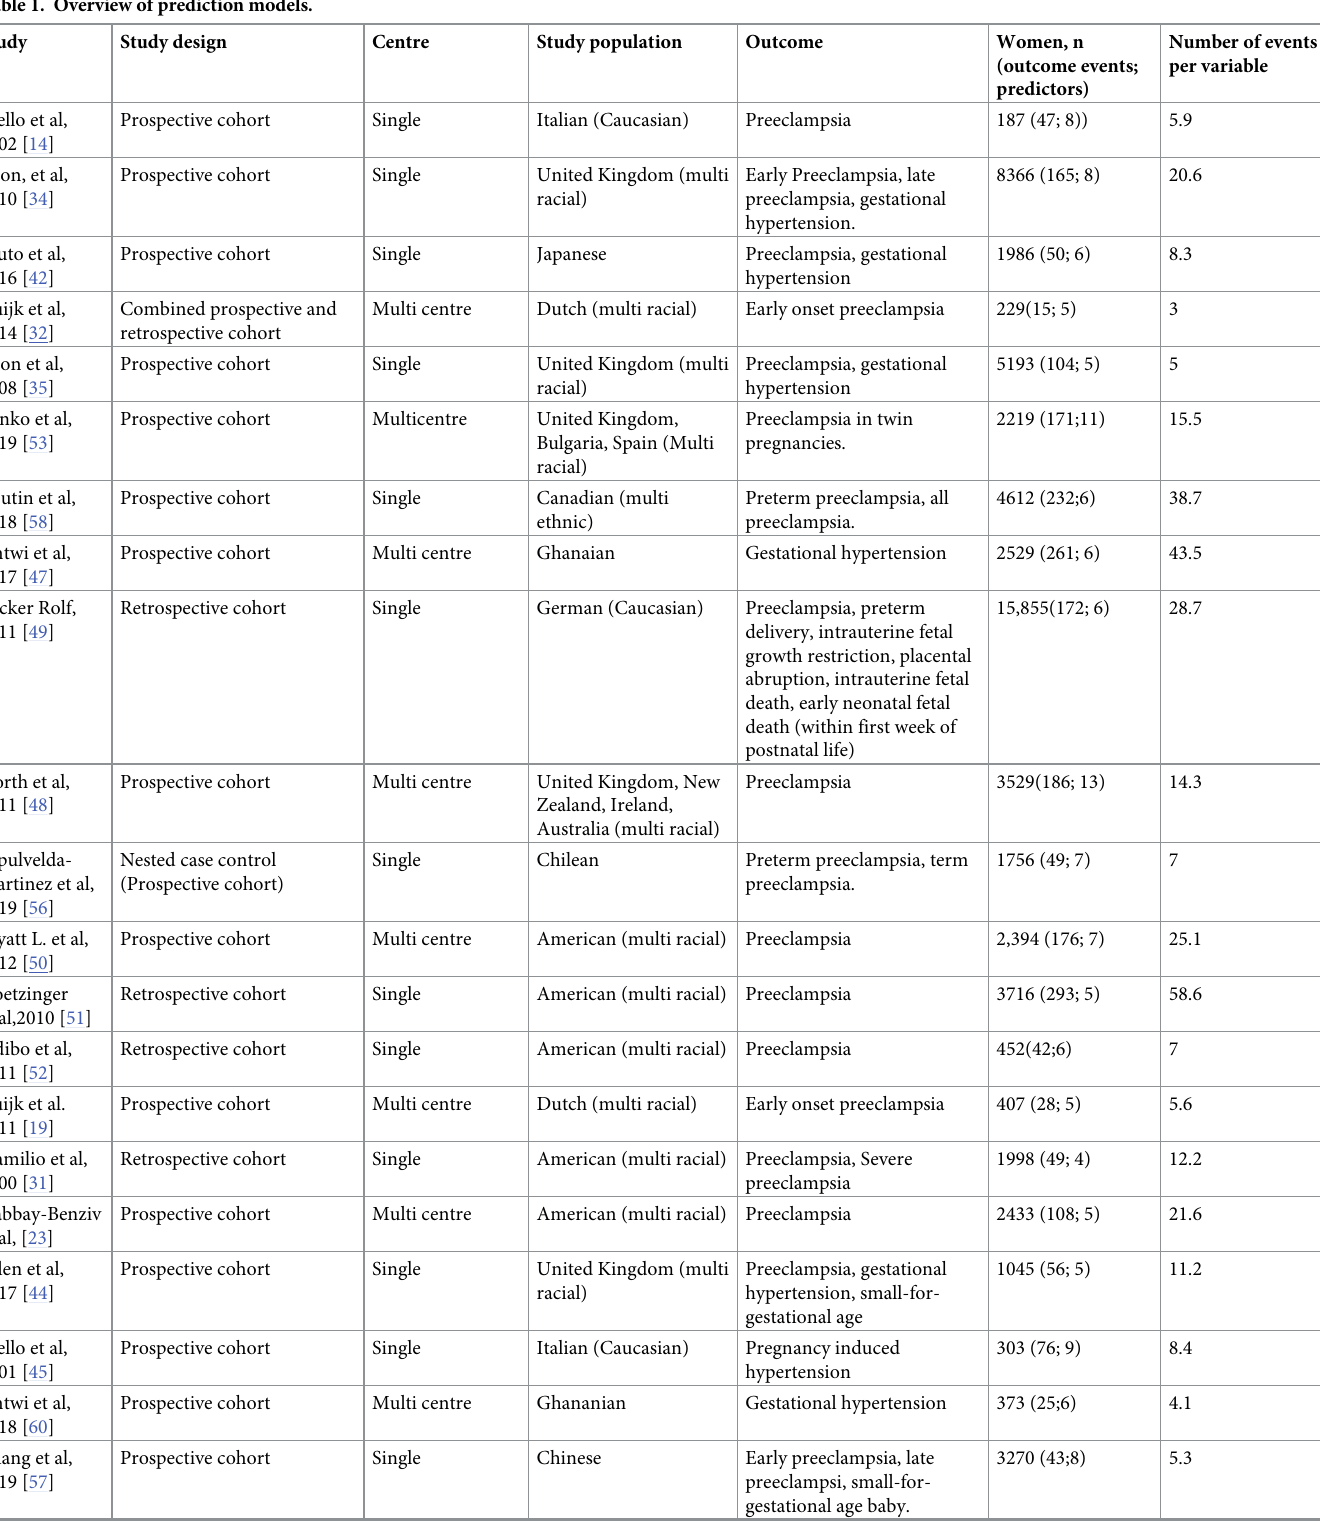
Table 1. Overview of prediction